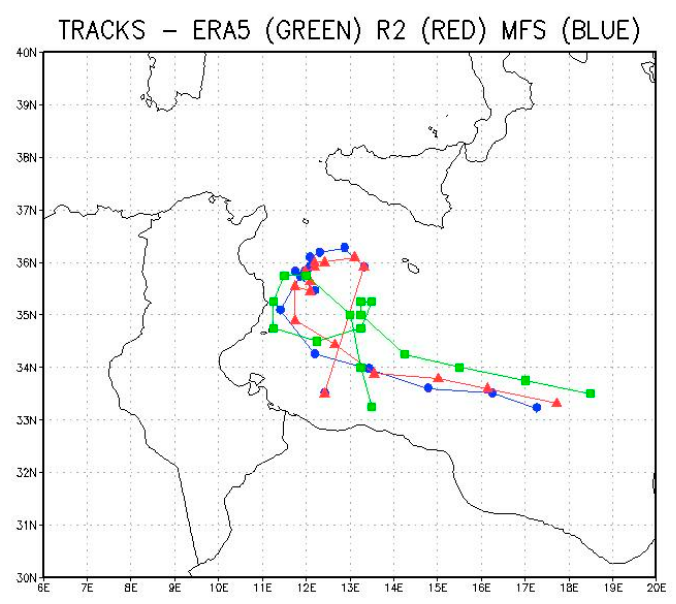
Figure 12. Storm tracks for the period 13 December 2005 00 UTC—15 December 2005 00UTC for the ERA5 reanalysis (green), the R2 run (red) and the MFS run (blue). The MSLP maps for the R2 and MFS simulations at the peak of the TLC on 14 De- cember 2005 03 UTC are shown in Figure 13. At this time the center of the TLC in the MFS run was located about 10 km to the east of the R2 center while the R2 central pressure was 0.9 hPa lower.